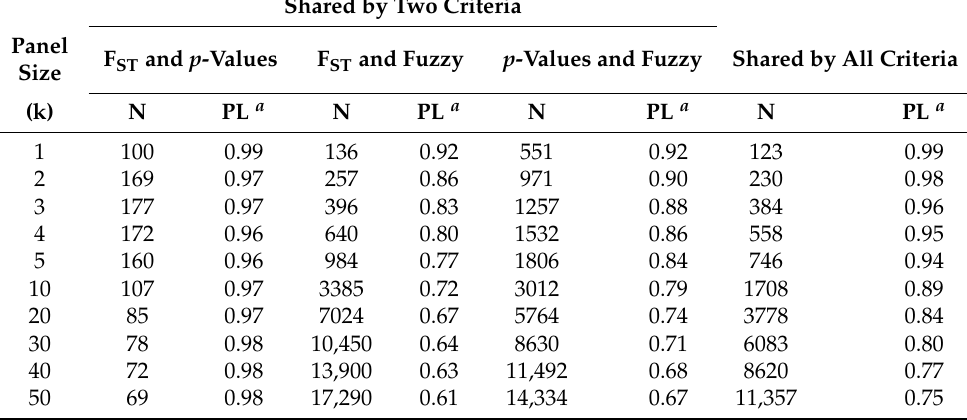
Table 7. The number of shared SNPs and proportion of shared SNPs that are linked with causative variants for F ST score, p -value, and fuzzy score preselection under a genetic architecture of 1 k causative